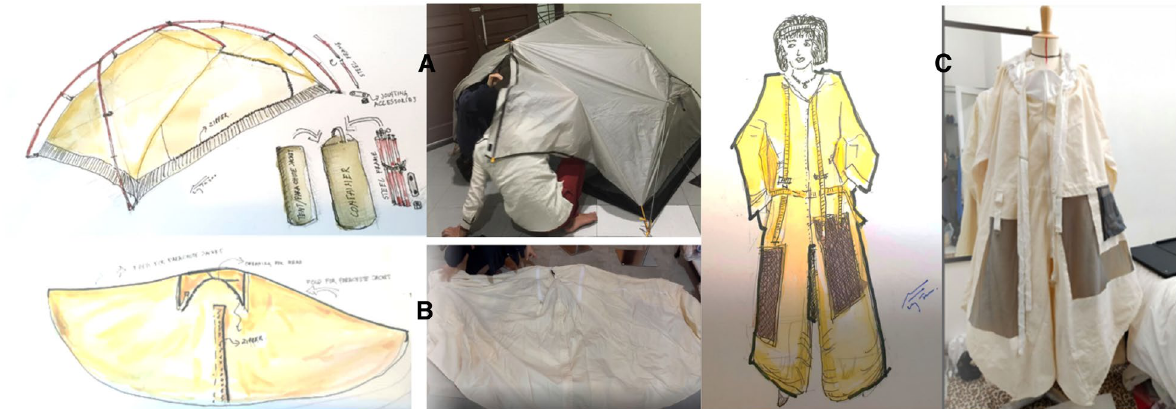
Fig. 2 Transformation of a tent into a parachute jacket packaged in a small and practical form. Source: Authors. A The parachute tent can be folded as small as possible and adjusted to the space requirements for one person. B The tent without a steel structure can be transformed into a parachute jacket. C Unisex parachute jacket is to deal with the